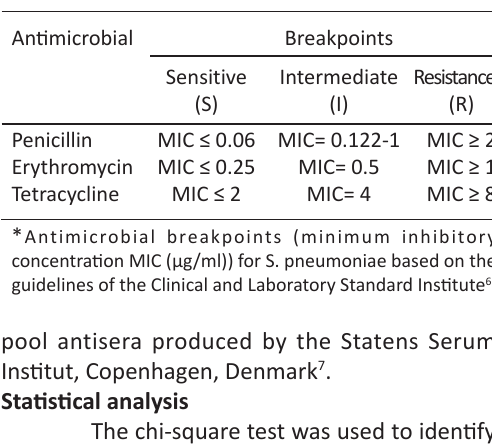
Table 2. Antimicrobial breakpoints for S. pneumoniae Antimicrobial